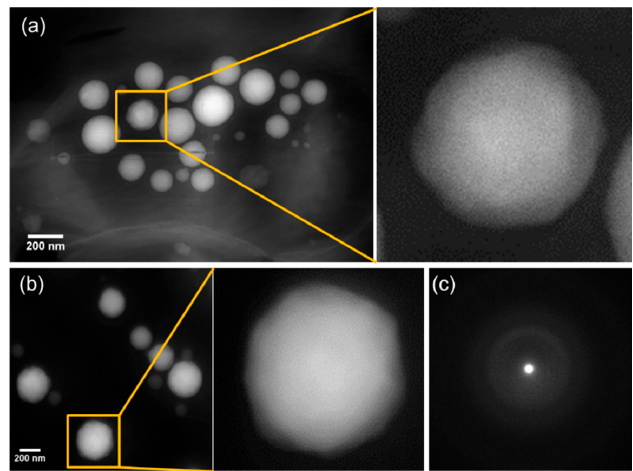
Figure 9. ( a – b ) High-magnification HAADF-STEM images showing that some Ca-carbonates appear to have some facets. ( c ) Zero-loss filtered selected area electron diffraction (SAED) pattern of one single carbonate particle such as the one indicated by the yellow square in ( b ) showing that it is electron diffraction amorphous.